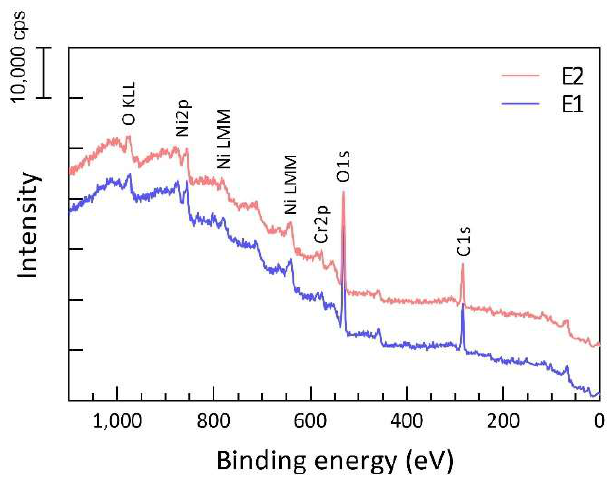
Figure 4. XPS survey spectra of powder E1 (blue) and E2 (red), indicating presence of surface oxide layer, covering powder in both cases.